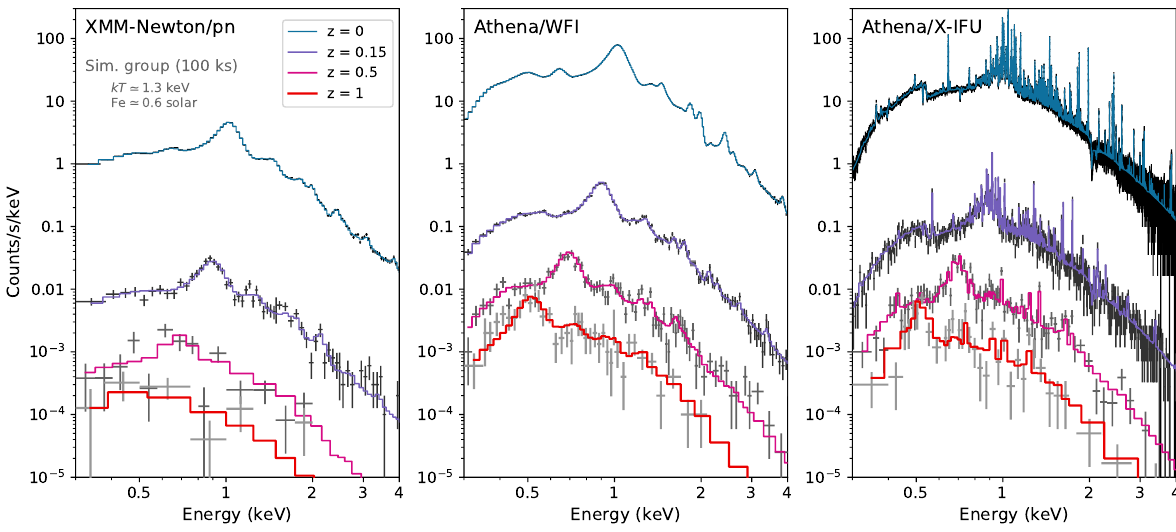
Figure 14. Simulated (100 ks) spectra of the core of a typical NGC1550-like group ( L 0.3 − 2keV (cid:39) 2.1 × 10 42 erg/s, kT (cid:39) 1.3 keV, Fe (cid:39) 0.6 Solar) set at various redshifts, as seen by the XMM- Newton /pn, Athena /WFI, and Athena /X-IFU instruments. Each spectrum has been appropriately re-binned for